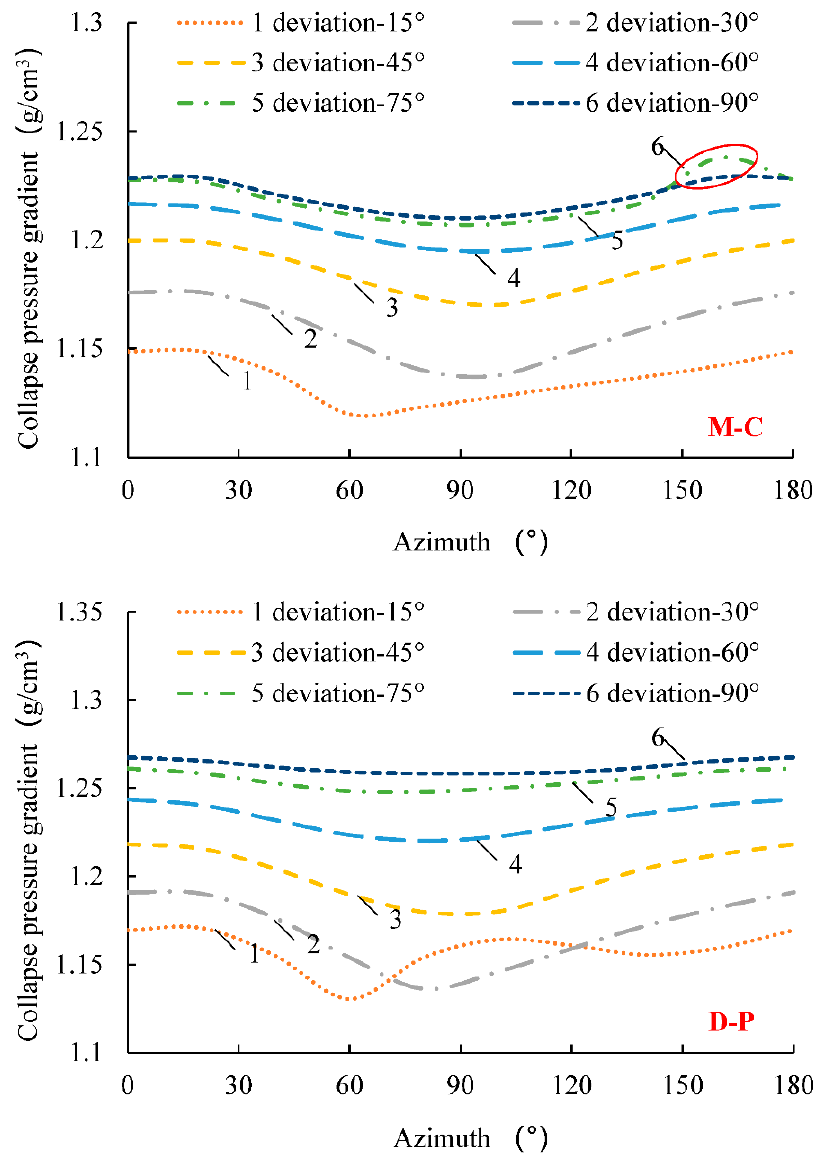
Figure 9. The azimuth and the collapse pressure gradient relationship curves by the two